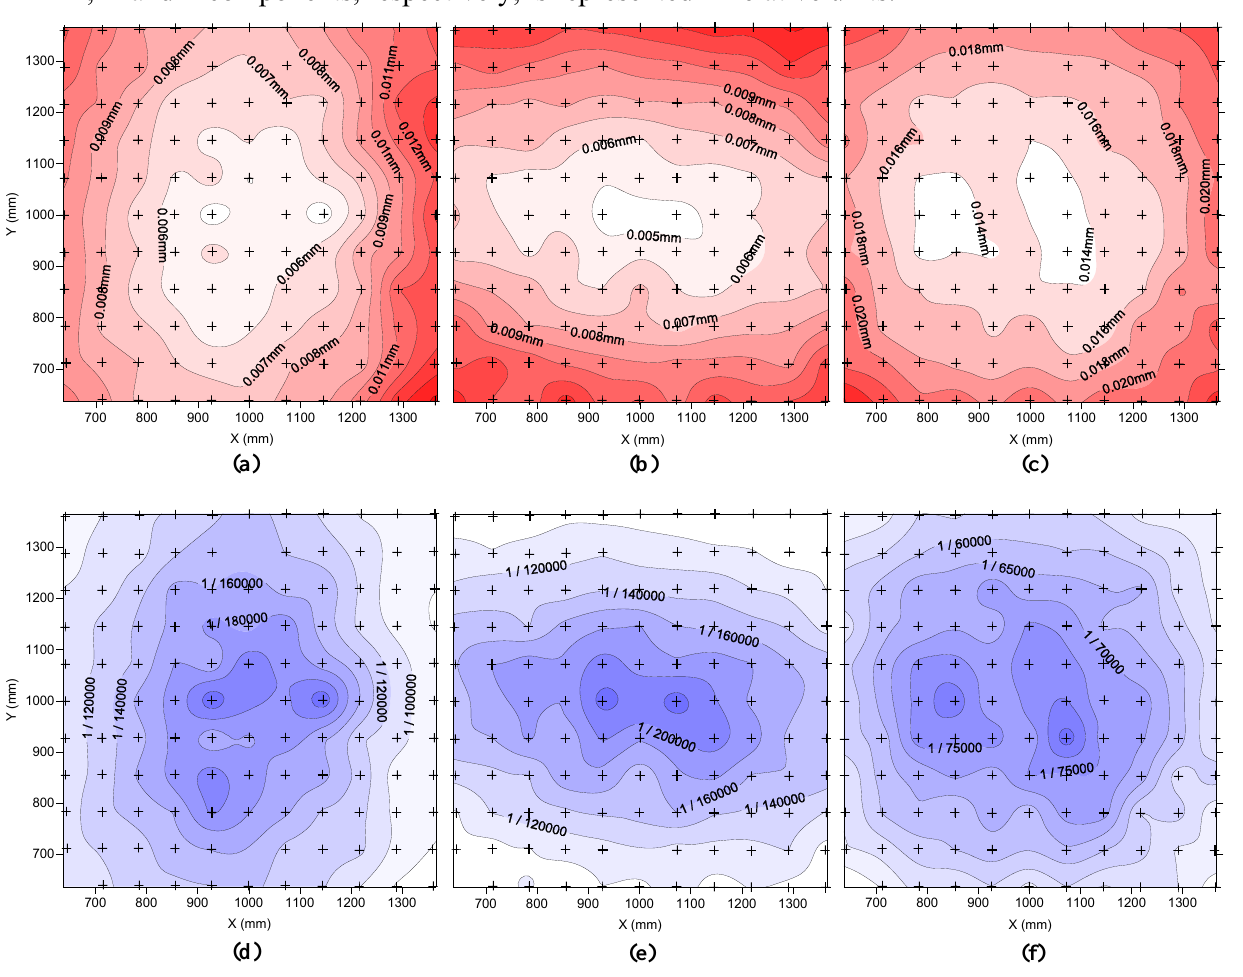
Figure 7. Spatial distribution of standard deviation (mm) obtained for the X ( a), Y (b) and Z (c) components of the 113 calculated coordinates. In (d), (e) and (f) standard deviation of X, Y and Z components, respectively, is represented in relative